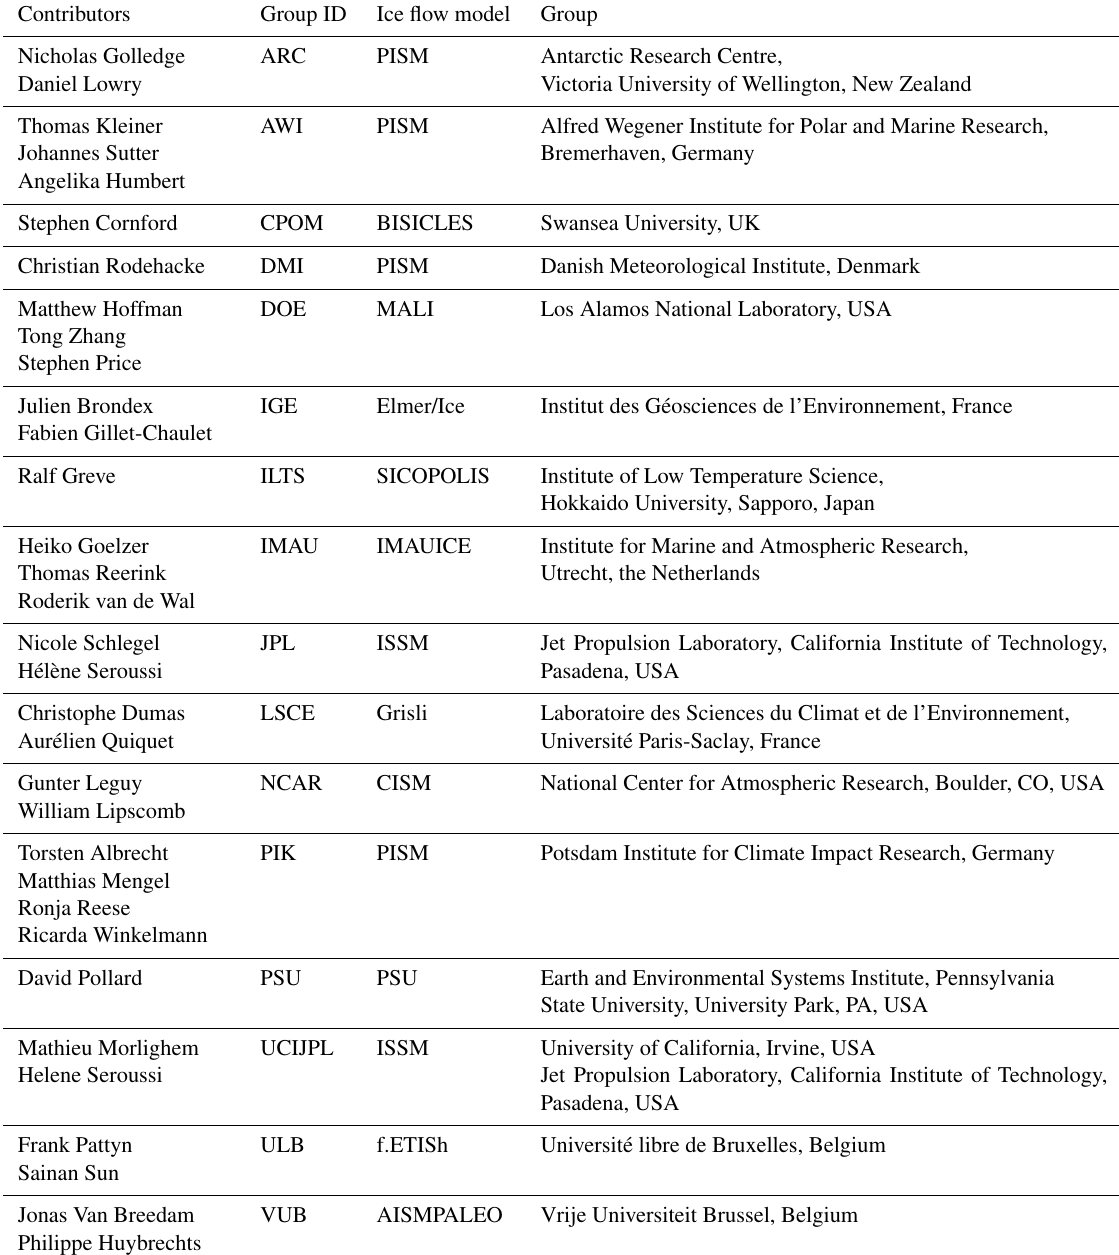
Table 1. List of participants, modeling groups, and ice flow models in ISMIP6 initMIP-Antarctica. Contributors Group ID Ice flow